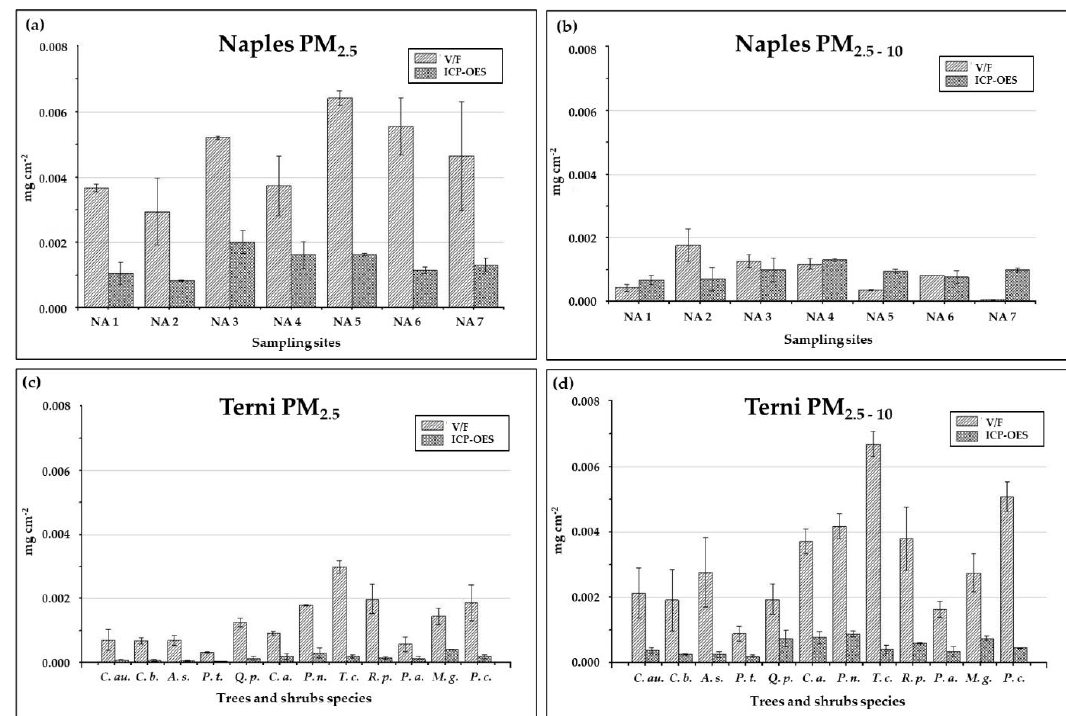
Figure 4. Load of insoluble fraction of leaf deposited particulate matter (PM) (mg cm − 2 ) detected gravimetrically (vacuum filtration, V/F) and through the chemical characterization (inductively coupled plasma - optical emission spectrometry, ICP-OES) of PM 2.5 ( a , c ) and PM 2.5-10 ( b , d ) membrane filters used to filter the washing solutions of the collected urban leaves. Int the different panels are reported data for PM2,5 ( a ) and PM 2.5-10 ( b ) from holm oak leaves collected in Naples and for PM2,5 ( c ) and PM 2.5-10 ( d ) from different tree species collected in Terni. Tree species are: Acer saccharinum ( A. c. ), Catalpa bignonioides ( C. p. ), Cedrus atlantica ( C. a .), Celtis australis ( C. au. ), Magnolia grandiflora ( M. g. ), Platanus acerifolia ( P. a. ), Populus nigra ( P. n. ), Populus tremula ( P. t. ), Prunus cerasifera ( P. c. ), Quercus pubescens ( Q. p ), Robinia pseudoacacia ( R. p. ) and Tilia cordata ( T. c. )). Each bar represents the mean of N = 2 replicates ± standard deviations.